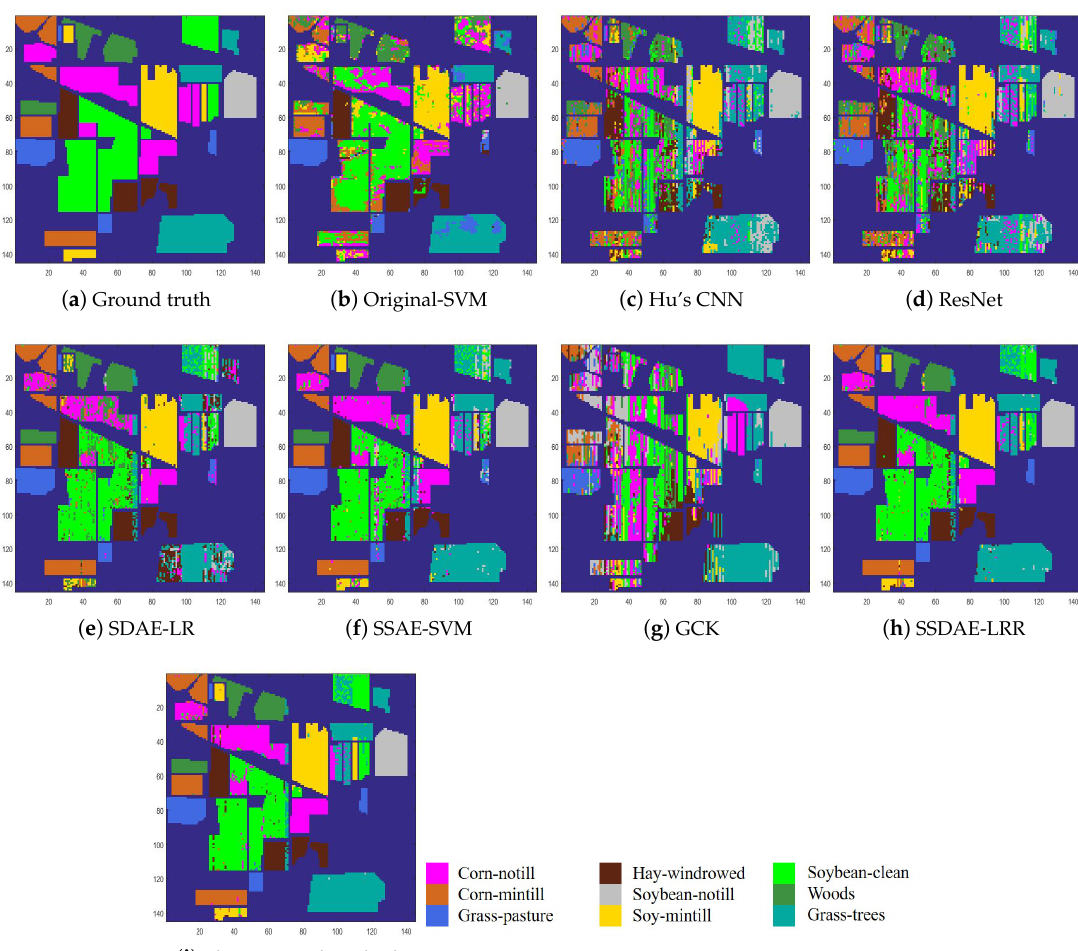
Figure 11. Classification maps of different methods on Indian Pines dataset (a total of 100 labeled samples were used for